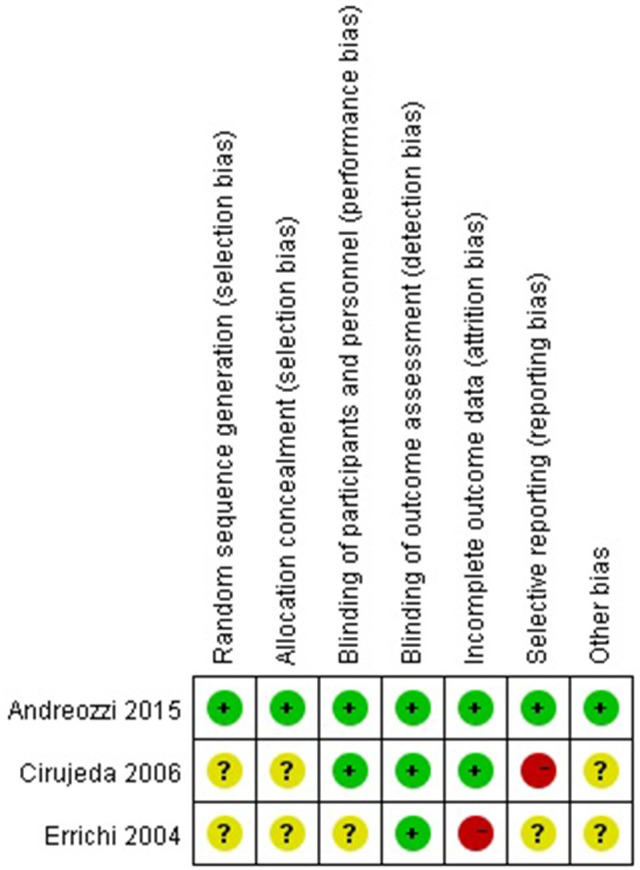
Methodological quality assessment of the risk of bias for each included study. Green circles indicate low risk of bias, yellow circles unclear risk of bias, and red circles high risk of bias.